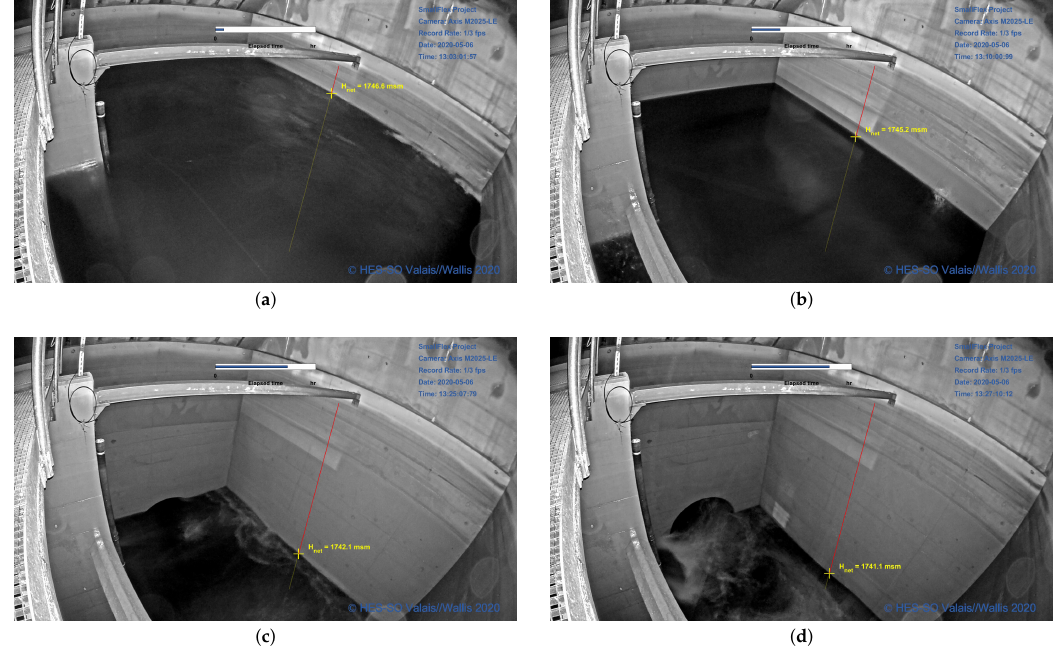
Figure 19. Free surface of the flow in the forebay tank at four different instants during the third peak. The red line and the yellow cross refer to the altitude of the free surface. ( a ) Free surface at the beginning of the peak, when the forebay tank is fulfilled, ( b ) free surface when the forebay tank is partially emptied, ( c ) free surface when it passes below the top of the head race tunnel, and ( d ) free surface passes when it passes through the middle of the head race